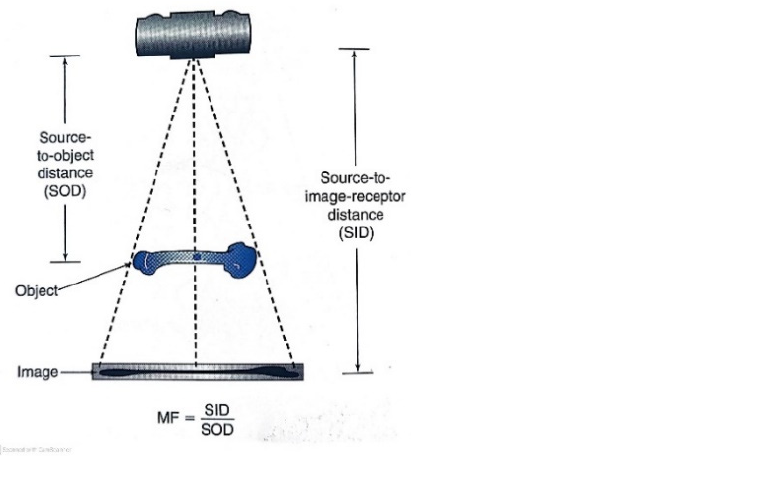
Figure 3. Illustration of the SID and SOD. IOD is the distance between the object and the image receptor